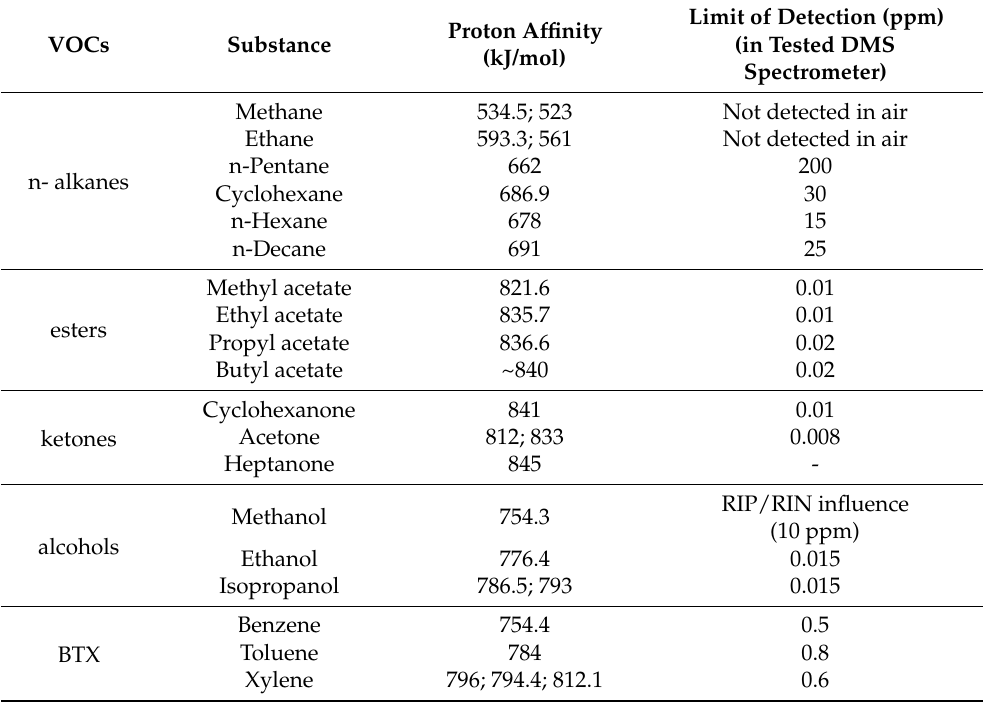
Table 1. PA values and DMS spectrometry detection limits for